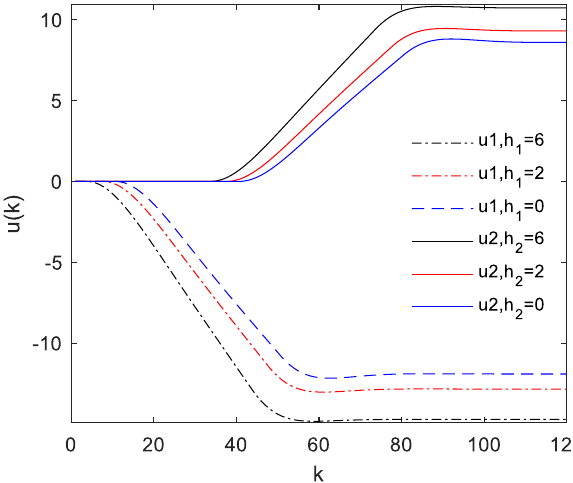
θ = 0, θ = 1, control of system (1) with di ff erent M Figure 12. 1 2 0, 1    , control of system (1) with different R M . Figure 12. 2 1 Figure 12. 1 2 0, 1    , control of system (1) with different R M .